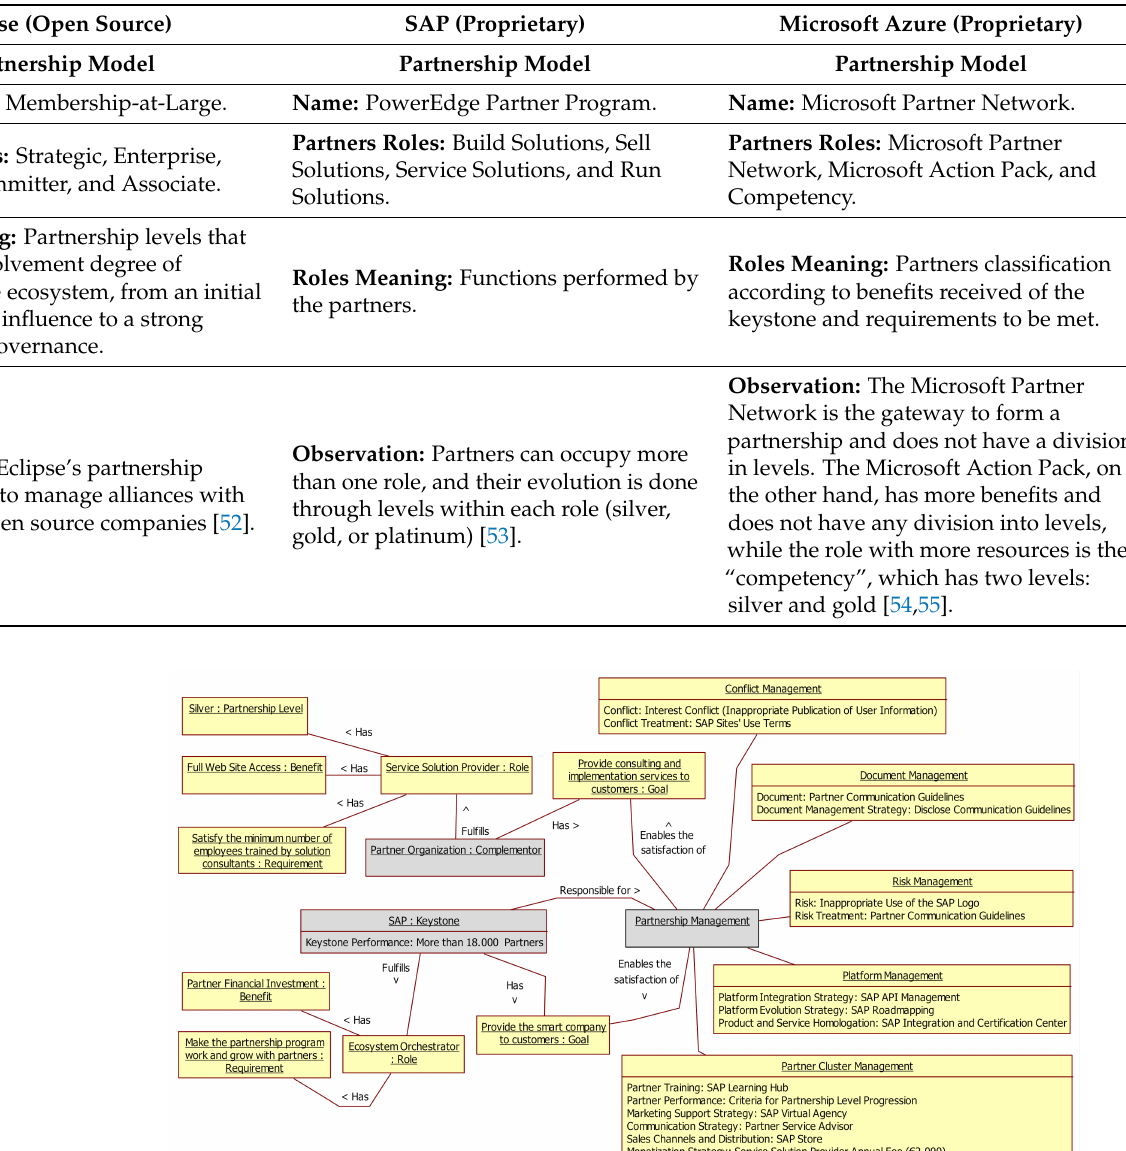
Table 5. Eclipse, SAP, and Microsoft Azure ecosystems overview.